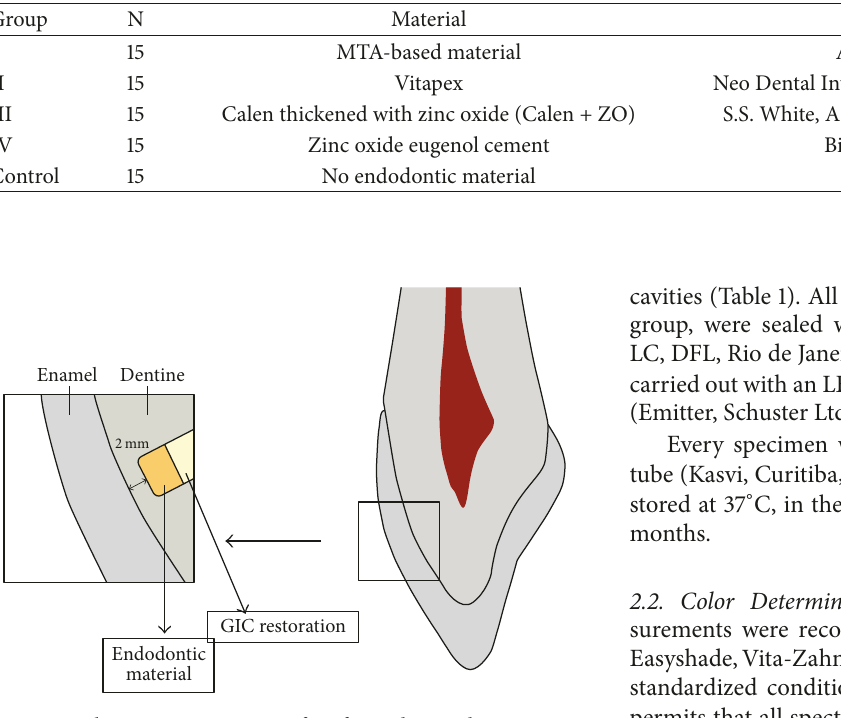
Figure 1: Schematic presentation of performed procedures prior to color